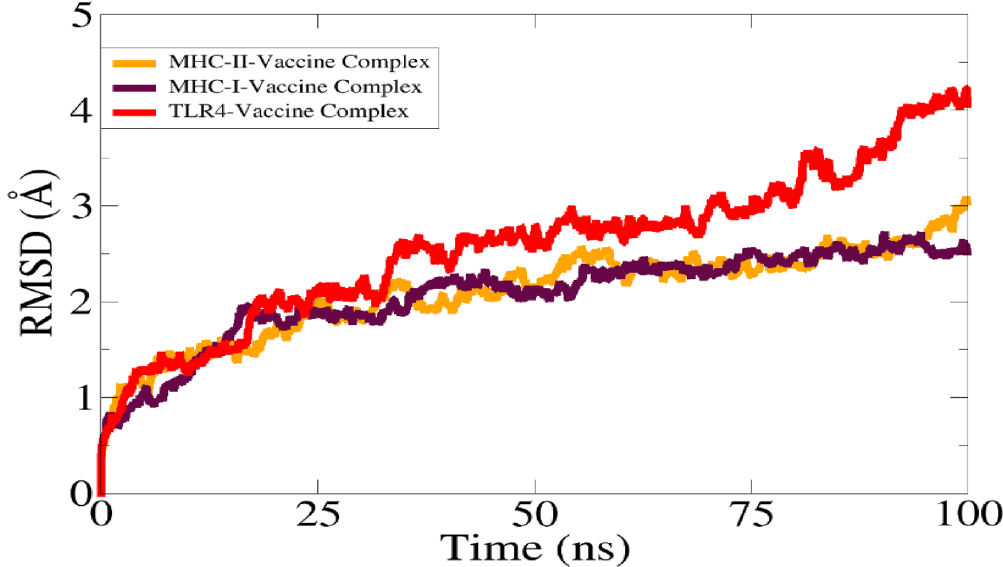
Figure 9. RMSD graph for analyzing simulations of